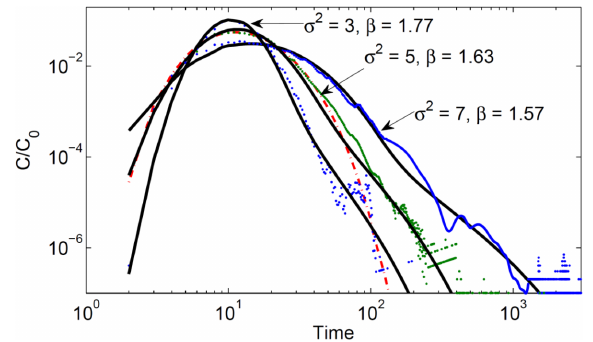
Figure 5. Breakthrough curves (points) for three ln (K) variances ( σ 2 = 3, 5, 7; 100 realizations each), at the domain outlet ( x = 300 length units), and corresponding CTRW fits (curves). Also shown is a fit of the advection–dispersion equation (dashed–dotted curve), for σ 2 = 5. See Sect. 3.3 for further discussion and explanation of β . All values are in consistent, arbitrary length and time units (after Edery et al., 2014; © with permission from the American Geophys- ical Union